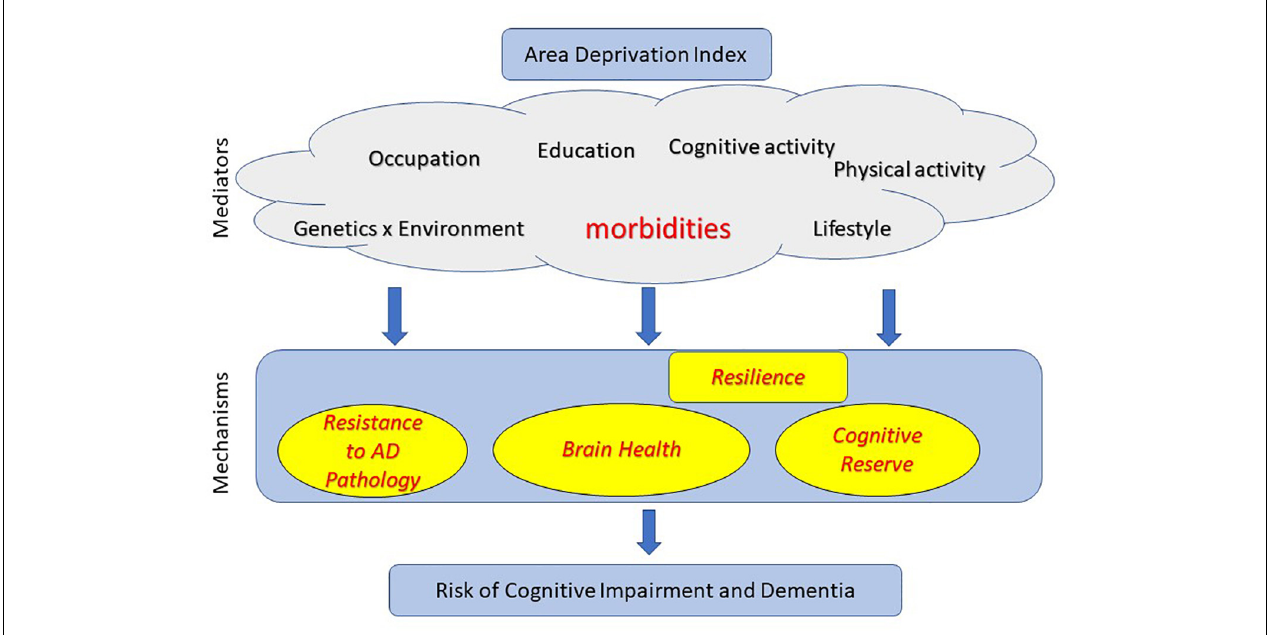
FIGURE 1 | Mechanisms through which area deprivation index (ADI) may influence risk of cognitive impairment, Alzheimer’s disease and Alzheimer’s disease related dementias